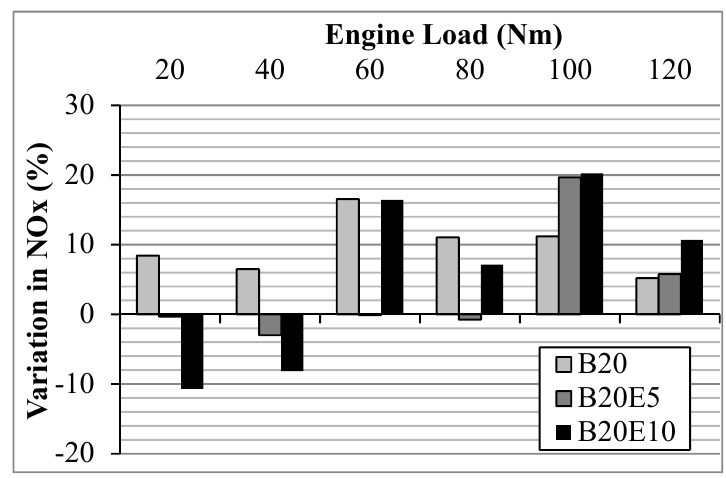
Figure 4. Variation in NOx emissions with the blends compared to diesel fuel as baseline.